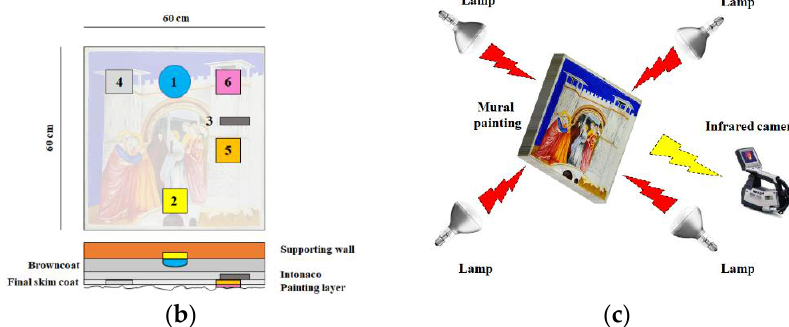
Figure 1. ( a ) Mock-up photograph, ( b ) defects map (detachment between the wall and the browncoat: void (1), moisture into the masonry: sponge soaked in water (2), detachment between the intonaco and the final skim coat: void (3), efflorescences: salts (4), cracks: sand (5), and flaking: poly-acetovinyl (6)), and ( c ) sketch of the experimental IRT setup.